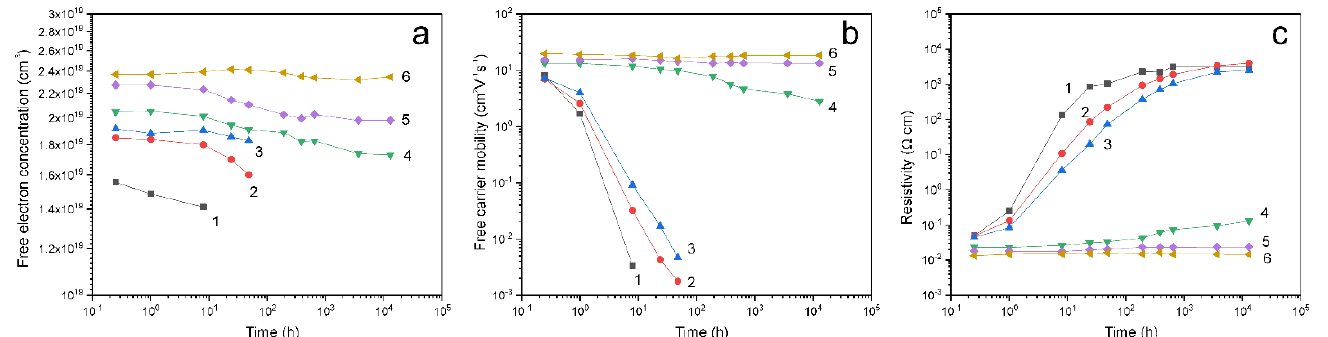
Figure 2. Concentration ( a ), mobility ( b ) and resistivity ( c ) of ZnO films: P-sample (1) and A + P samples annealed in air for 30 min at a temperature of 100 °C (2), 175 °C (3), 250 °C (4), 325 °C (5) and 400 °C (6) followed by treatment in hydrogen plasma for 3 min versus aging time.